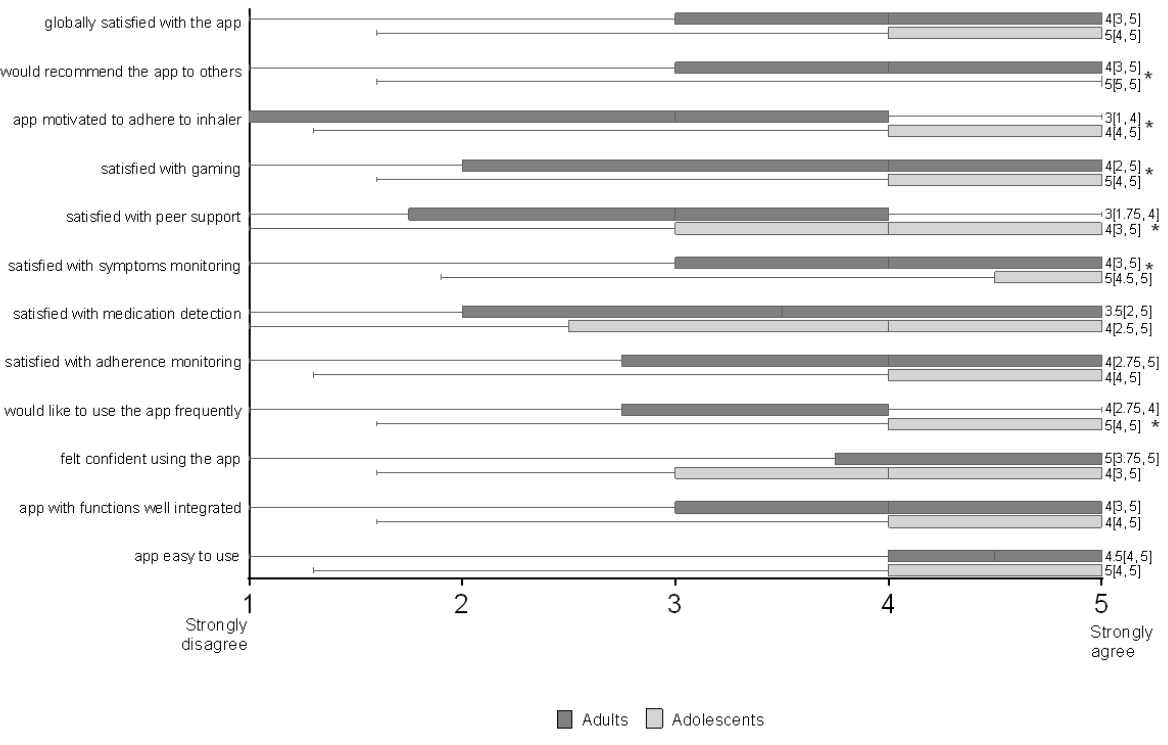
Figure 4. App feedback from adolescents and adults (n=79). Data are presented as box plots (lines inside the boxes represent the medians; bounds of boxes, first and third quartiles; bars, 95% confidence interval). *Significant differences between adolescents and